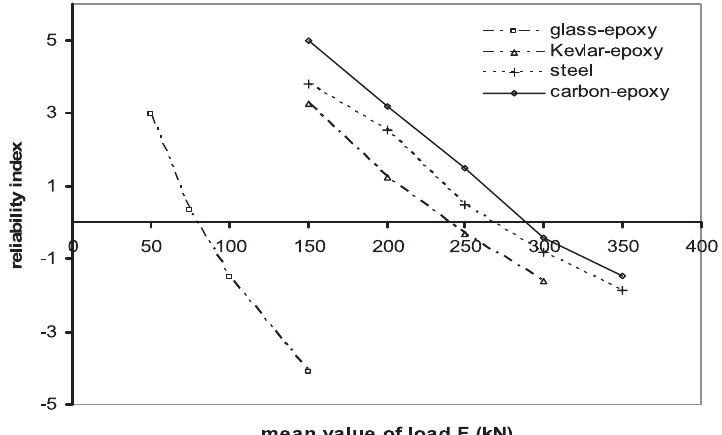
Fig. 8. Reliability index β according to axial load F ( q = 0 MPa).